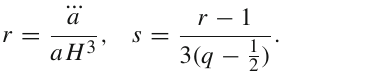
Fig. 24 Illustrative examples for the statefinder diagnostic { r , s } of IBHDEHL. Present values of { r , s } are marked by black dots, while the present values of the (cid:4) CDM model is a fixed point { r , s } = { 1 , 0 } marked by the red dot. Here, we take (cid:5) = 0 .